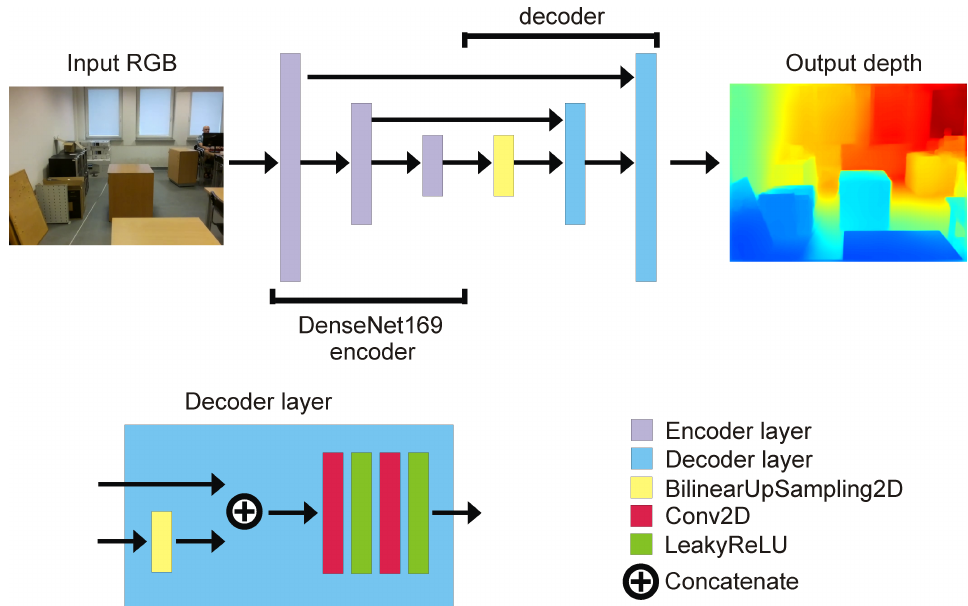
Figure 1. Deep encoder–decoder architecture of proposed network for RGB to depth image